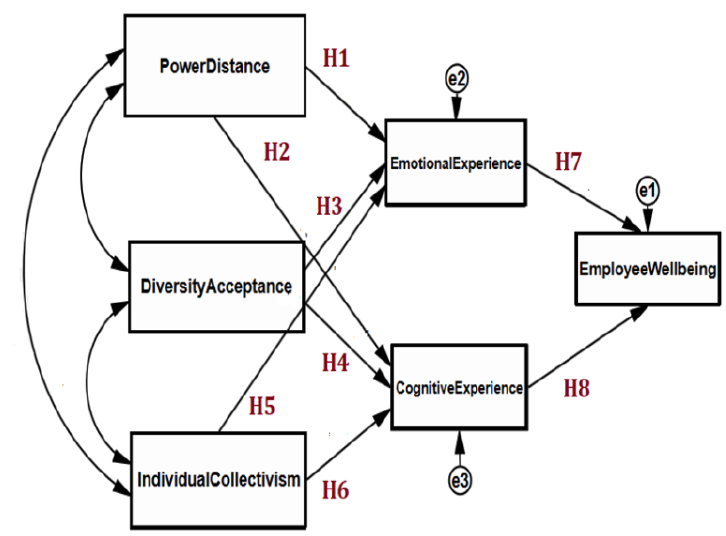
Figure 2: Structural model